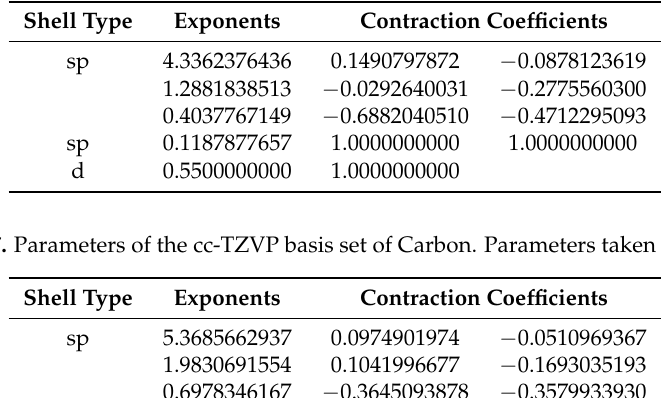
Table A6. Parameters of the cc-DZVP basis set of Carbon. Parameters taken from [80].